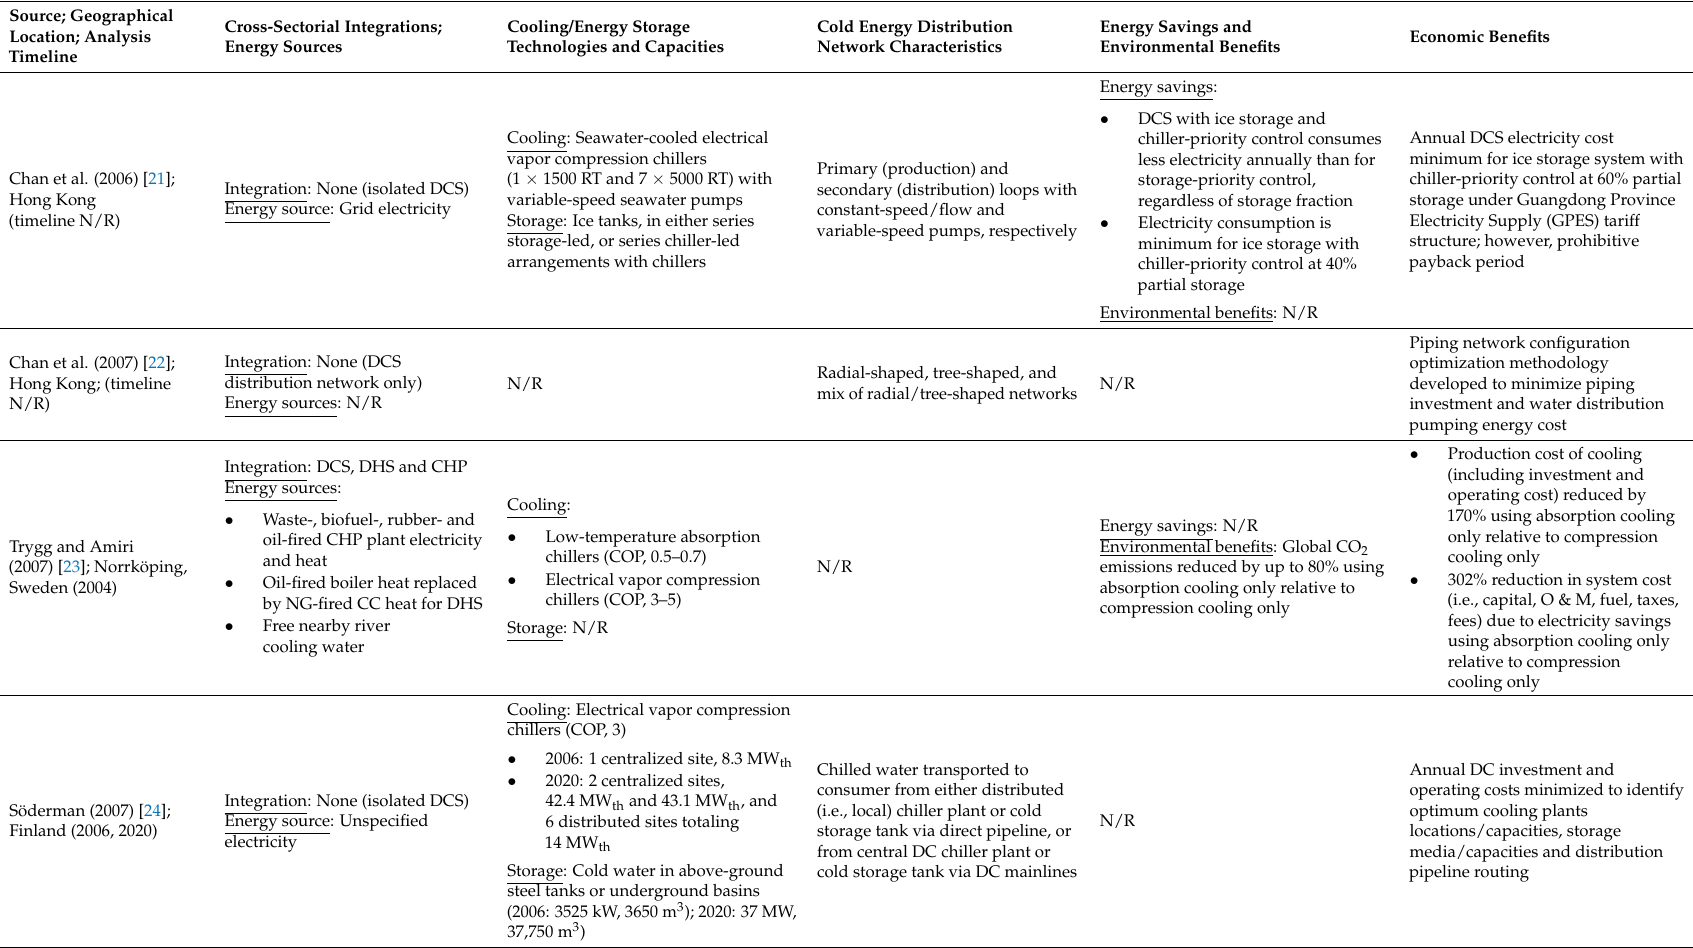
Table 1. Overview of published design and analysis studies of DC systems with sustainable energy